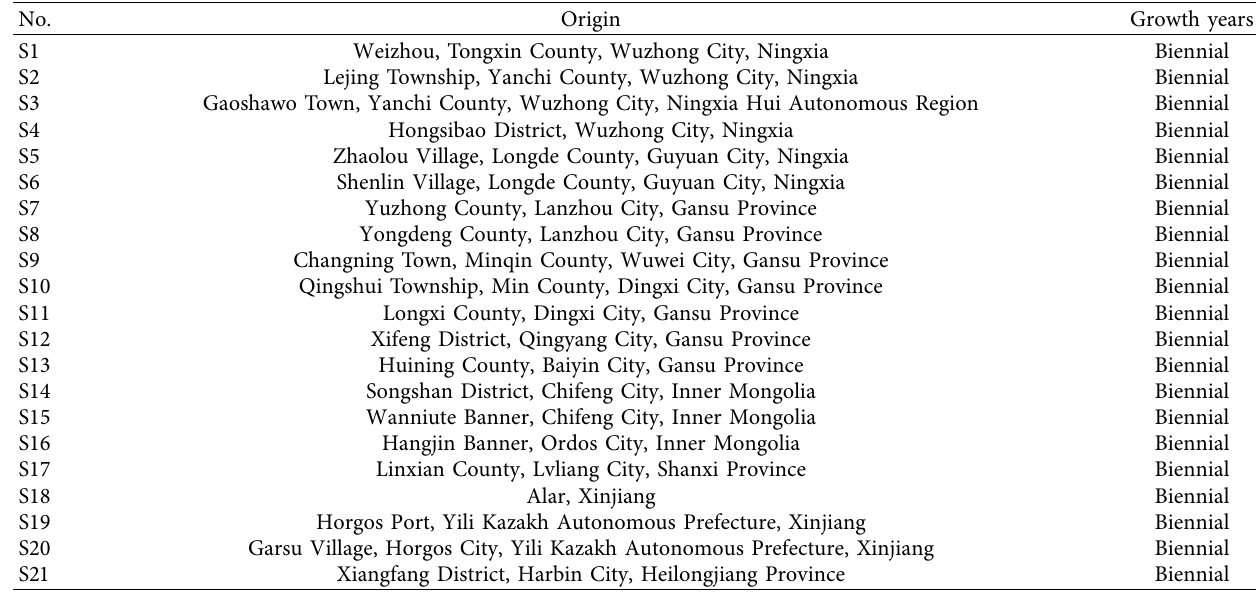
Table 1: Glycyrrhiza uralensis Fisch. sample source information table.